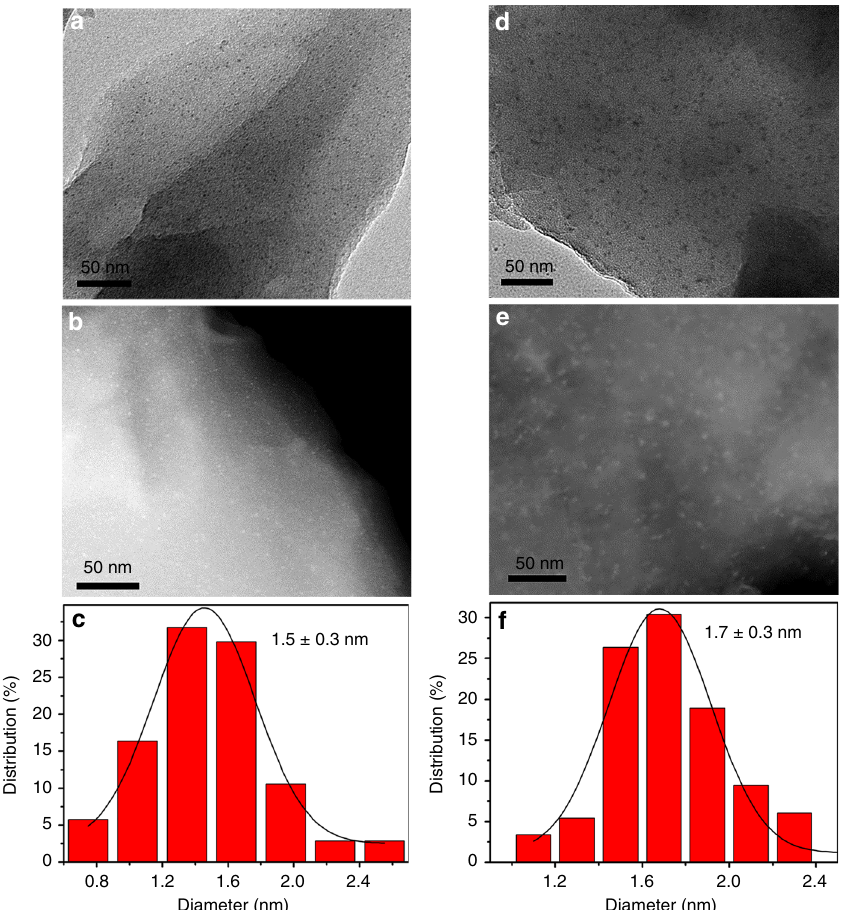
Fig. 1 TEM, HAADF-STEM images and size distribution. a TEM, b HAADF-STEM images, and c the corresponding size distribution of Pt NPs in Pt@MIL- 101. d TEM, e HAADF-STEM images, and f the corresponding size distribution of PtCu NPs in Pt 1 Cu 2